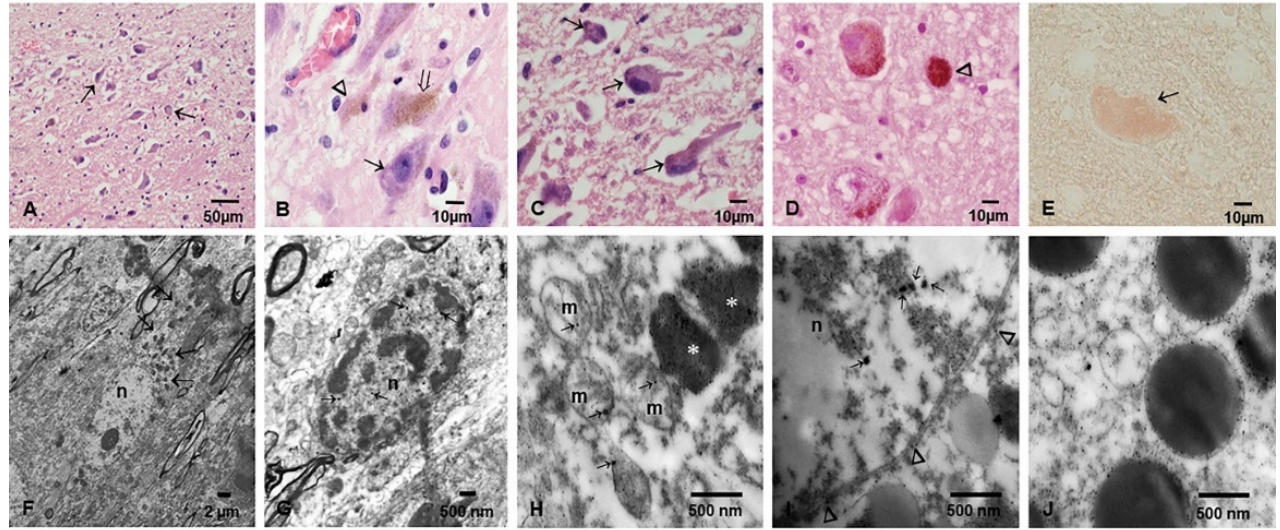
Figure 5. Locus coeruleus light and electron microscopy. ( A ). LC in a 17 year-old male, neurons are marked with short arrows (H&E). ( B ). A 14-year-old girl; notice the contrast between an apparently intact cell (open arrow), a neuron totally devoid of neuromelanin (short arrow) and a macrophage packed with NM (arrowhead). ( C ). A close-up of A to show the rounded appearance of the ill-defined neurons (short arrows). ( D ). A 27-year-old male with macrophages packed with NM (arrowhead) alongside intact and degranulated neurons. ( E ). Fourteen-year-old girl with α -synuclein + neuron (red product, no contrast staining). ( F ). LC neuron with numerous NM granules (short arrows) in a 33-year-old male. ( G ). A close-up of a LC neuron in a 11-year-old child with numerous NPs in the nucleus (n) (short arrows) and very ill-defined cytoplasmic borders. ( H ). Same 11-year-old, several lysosomal bodies (*) with NPs and every single mitochondrion with fragmented cristae and NPs (short arrows). ( I ). Same as ( G , H ), numerous NPs inside the nucleus (short arrows) and NPs going through the nuclear pore complexes (arrow heads). ( J ). Significant number of dark lysosomal structures decorated with NPs and surrounded by ill-defined organelles and NPs.